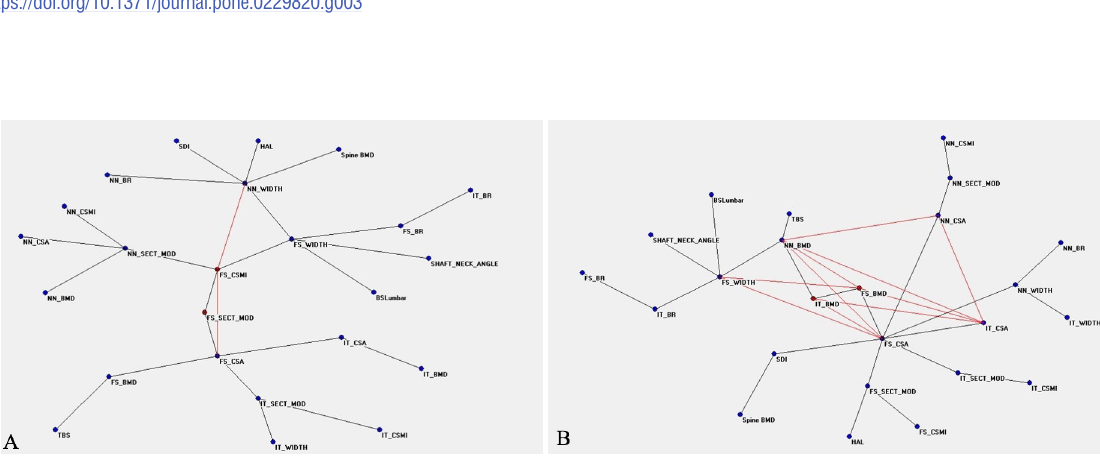
PLOS ONE | https://doi.org/10.1371/journal.pone.0229820 March 11,